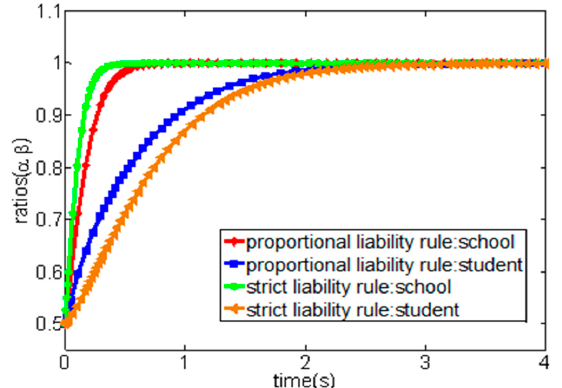
Figure 3. The evolution process of the system game strategy under the condition of high ratios of the prevention cost that school should undertake (case 2).